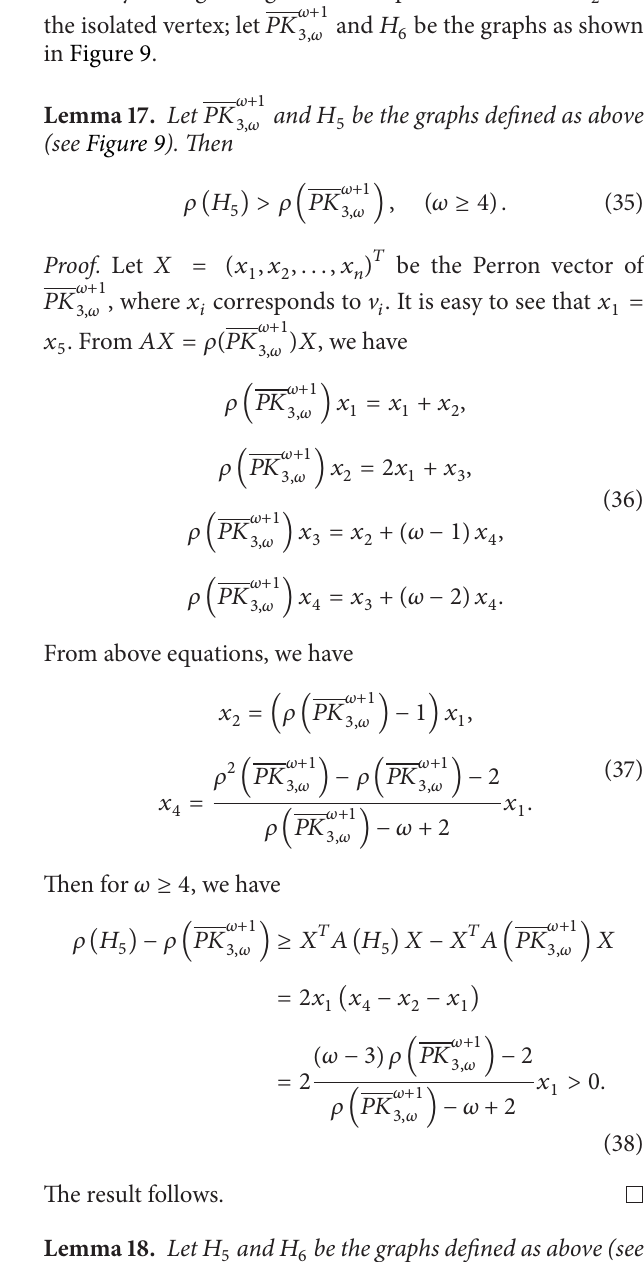
Figure 9: Graphs 𝑃𝐾